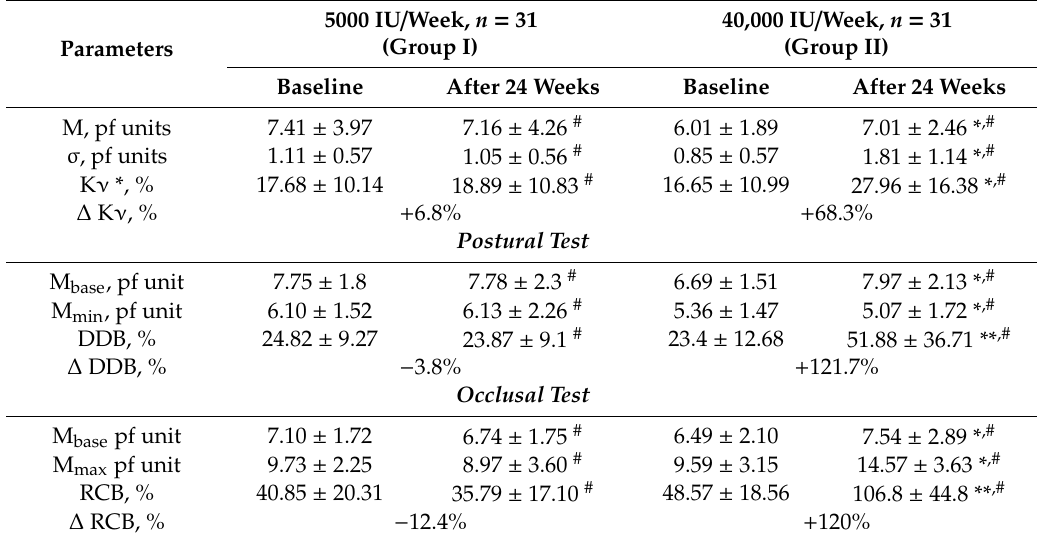
Table 3. Microcirculation parameters at baseline and after 24-week